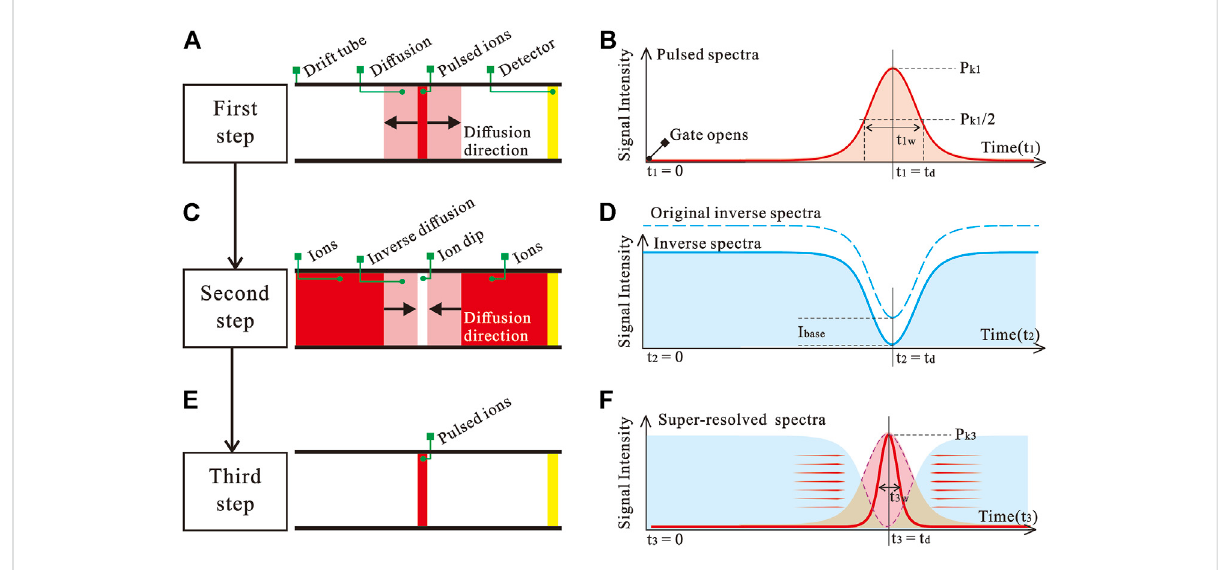
The steps of the inverse diffusion counterbalance method implementation. (A) Drift process of pulsed ion packet. (B) Schematic spectrum of a pulsed ion packet. (C) Drift process of inverse dip in ion beam. (D) Schematic inverse spectrum. (E) Pulsed ion packet after counterbalance. (F) Schematic spectrum that breaks the resolution